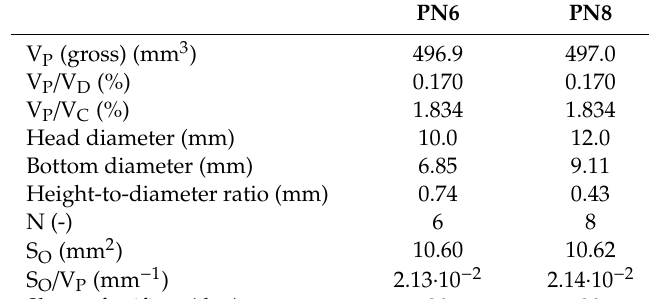
Table 4. Geometric characteristic of the six-orifice (PN6) and eight-orifice (PN8) prechambers.